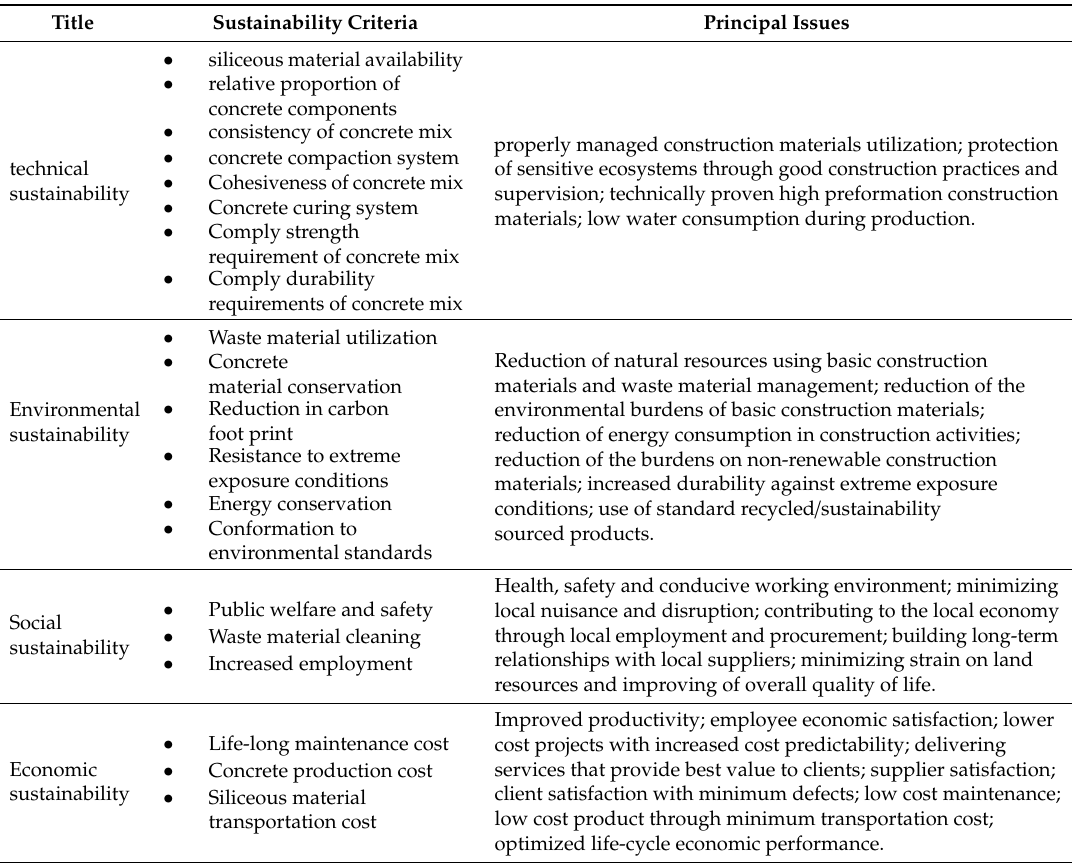
Table 1. Sustainable criteria along with sustainability indicators (sub-criteria) for selection of siliceous concrete materials and their principal issues.